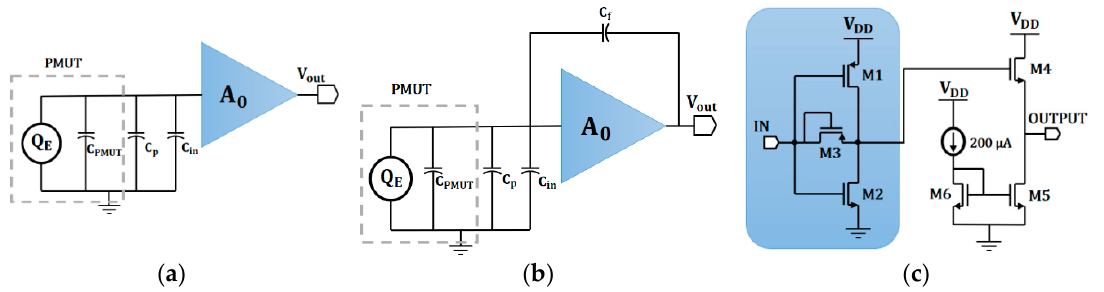
Figure 5. PMUT front-end amplifier configurations: ( a ) a voltage amplifier (VA) based on capacitive integration, ( b ) a CSA amplifier, and ( c ) a proposed schematic for the open-loop voltage amplifier, A 0 , for the VA and CSA receivers.